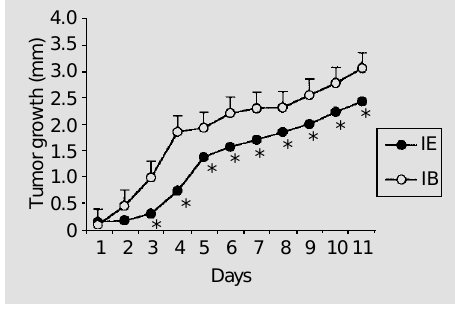
Figure 2 – Photomicrograph showing the NGF/EGF-positive tumor cells in groups IB (A) and IE (B). Note the differences in staining intensity between A and